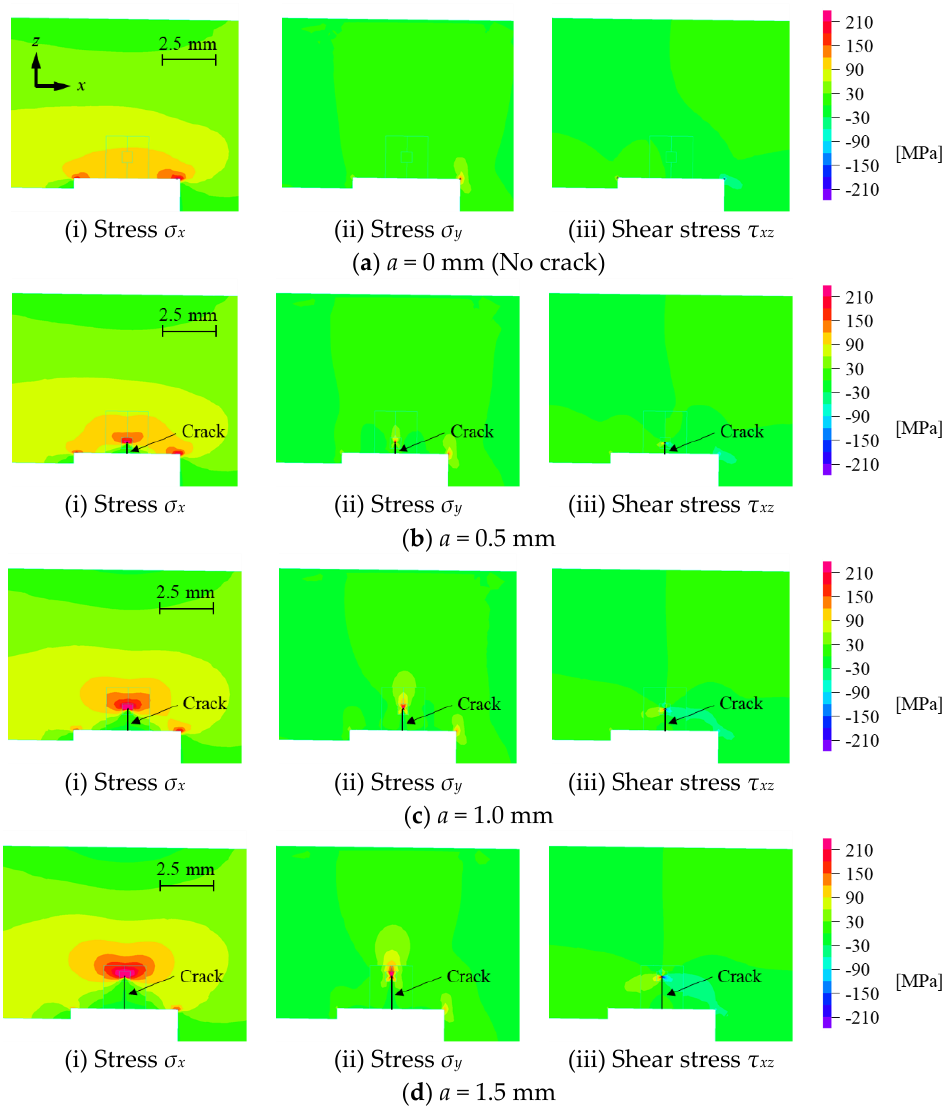
Figure 6. The stress σ x , σ y , and shear stress τ xz distribution above the cooling passage of Model 2D, a = 0, 0.5, 1.0, 1.5 mm. ( a ) a = 0 mm (No crack); ( b ) a = 0.5 mm; ( c ) a = 1.0 mm; ( d ) a = 1.5 mm.